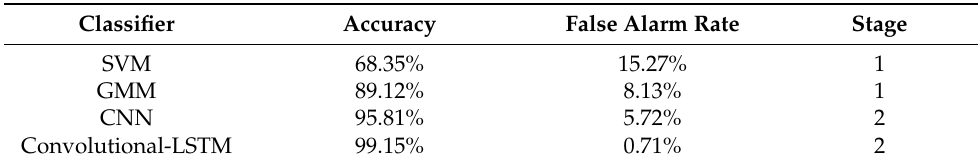
Table 4. Detection performance using different classifiers.